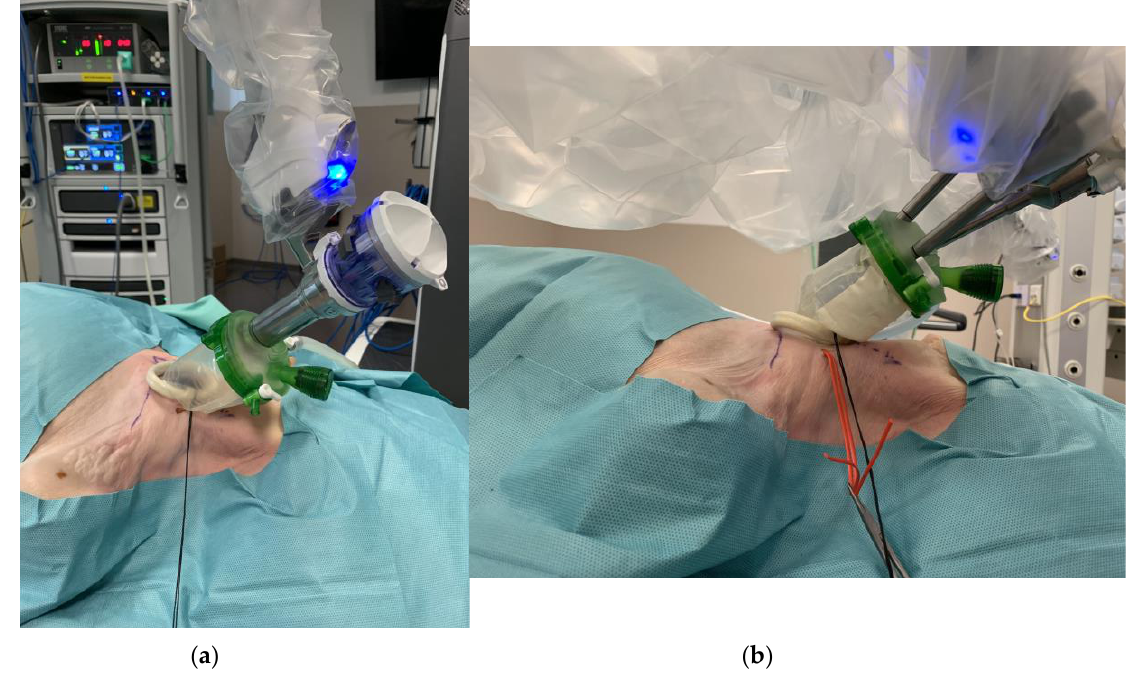
Figure 3. da Vinci SP ( a ) and Xi system ( b ) docked to the sleeve on the left side of the neck.